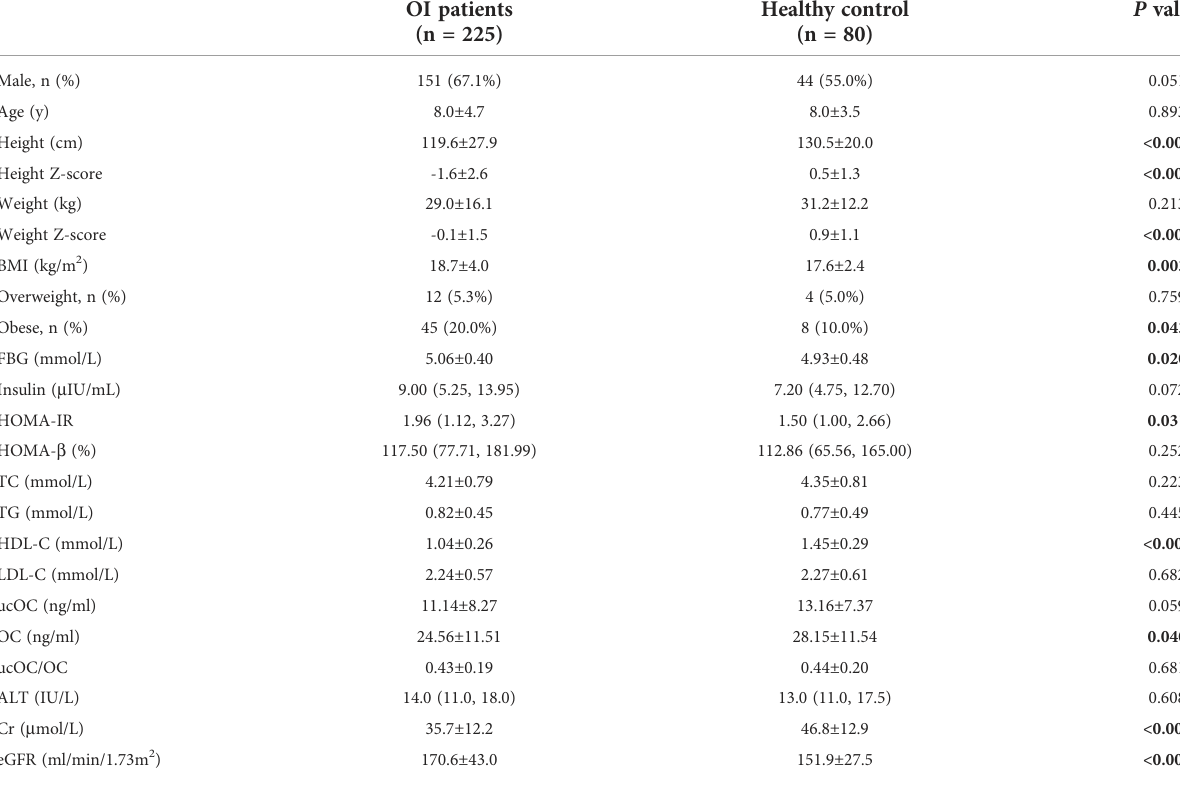
TABLE 1 General characteristics of OI patients and control